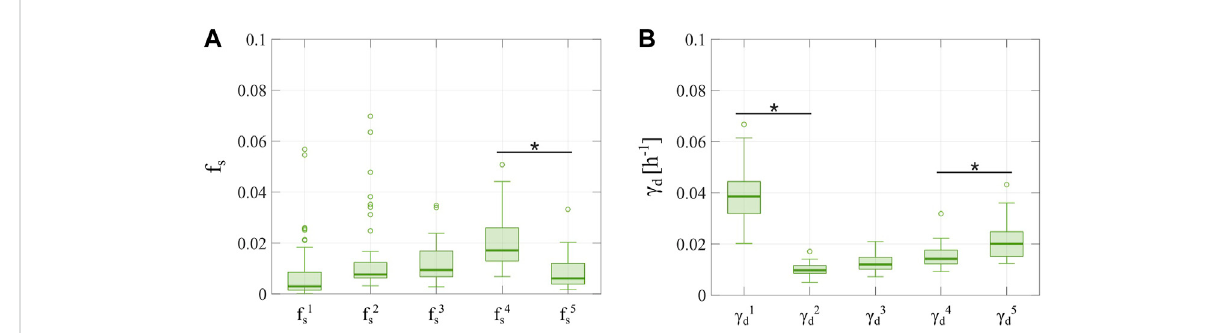
FIGURE 9 Distributions of f s and γ d obtained from fi tting the multiple-dose model to the experimental data for a varying number of doses with a 2-week inter-treatment interval. The parameter distributions are represented as boxplots and were obtained from fi tting the multiple-dose model to the 2- week inter-treatment interval datasets from Experiment 3 (Table 1), in which the model with varying f s and γ d was used. Outliers are represented as circles. Panel (A) shows the distributions of the fraction of surviving cells, such that anew value for f s is de fi ned for each drug dose ( f 1 s , f 2 s , ... , f 5 s ). We observe an increasing trend in the fi rst four f s parameters, which suggests an increasing chemoresistance with each dose. However, f 5 s takes on signi fi cantlylowervaluesthan f 4 s ( p (cid:1) 0 . 0015),whichsuggeststhataddingmoredosesmaylimitthetrendtowardschemoresistance.Panel (B) shows the distributions of the doxorubicin-induced death delay rate of irreversibly damaged cells, such that a new value of γ d is de fi ned for each drug dose ( γ 1 d , γ 2 d , ... , γ 5 d ). The values for γ 2 d are signi fi cantly lower than those of γ 1 d ( p (cid:1) 5 . 6 × 10 − 19 ). Hence, the second irreversibly damaged subpopulation shows a slower transition to treatment-induced death. However, the subsequent doxorubicin doses induce irreversibly damaged